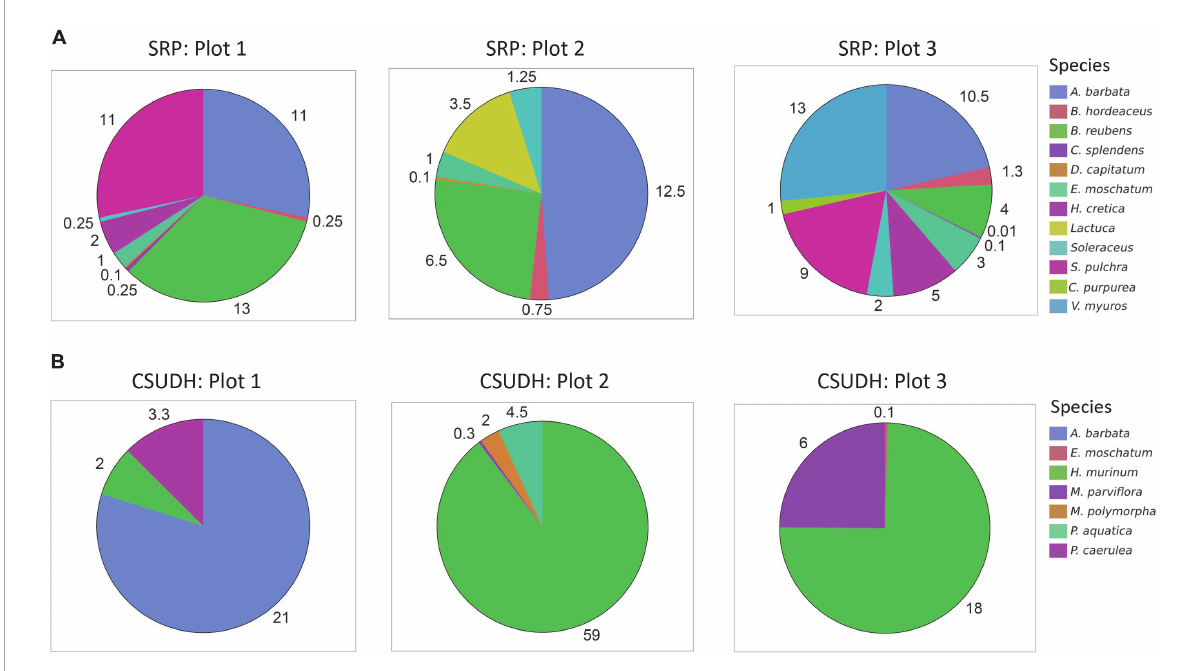
FIGURE4 Pie charts showing the species distributions at each quadrat at two of our field sites. (A) Percent abundance of present species at our least developed site, the Santa Rosa Plateau Ecological Reserve. At these plots there was relatively high diversity, but nearly identical species in each of the three quadrats. (B) Percent abundance of present species at our most developed site, California State University- Dominguez Hills. At these plots there were no native species present, with different exotic species dominating